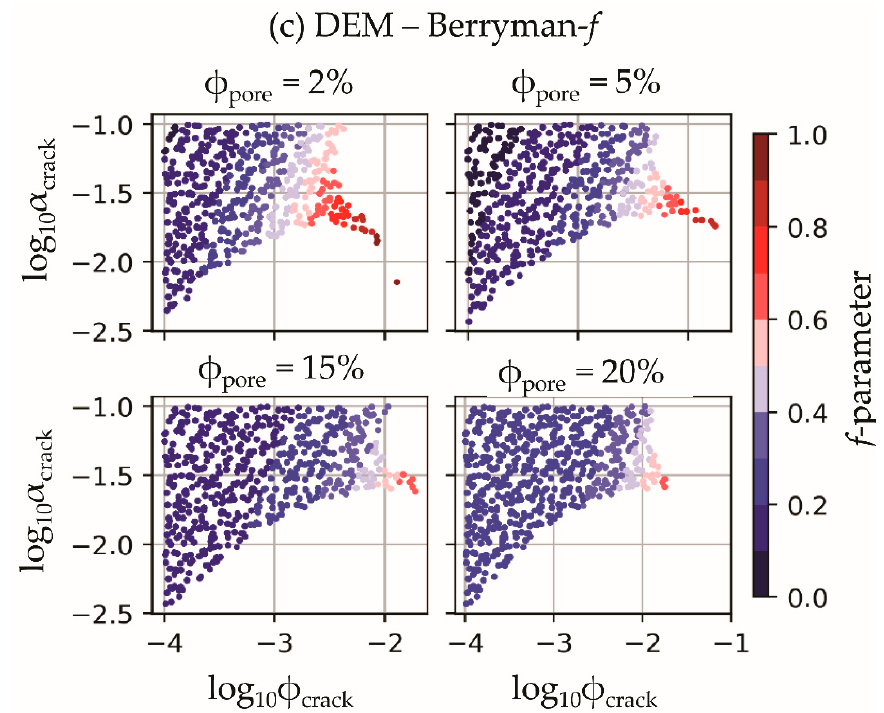
Figure 2. Crack aspect ratio and crack porosity vs. f -parameter as a color for fixed spherical porosity values. Voids are brine saturated. Calculations are performed for three pairs of methods: ( a ) GSA- SC—GSA- f , ( b ) Berryman-SC—Berryman- f , and ( c ) DEM—Berryman- f . Each color point is related to a solution for aspect ratio and crack porosity provided by Type 1 model. The color is controlled by the f -parameter value provided by Type 2 model.